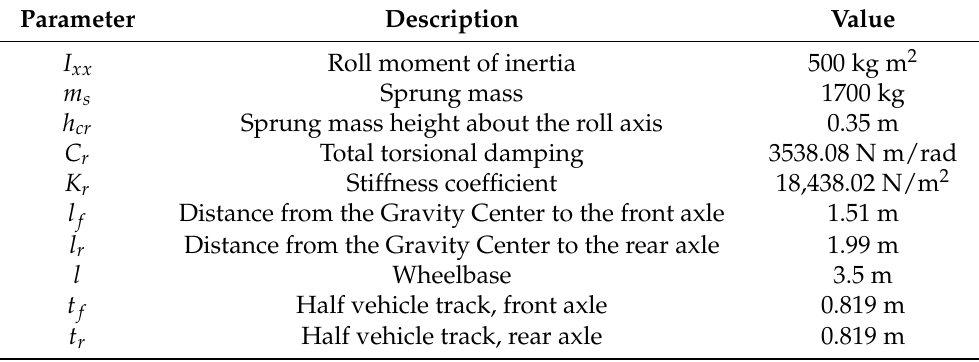
Table 1. Vehicle